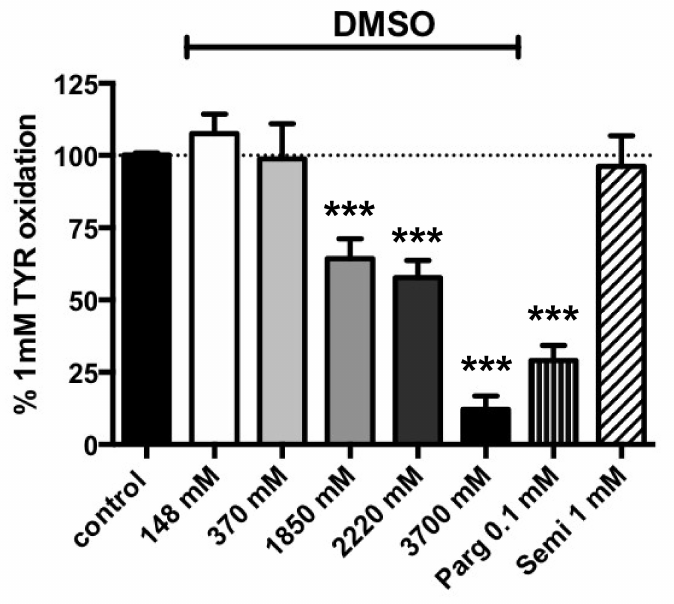
Figure 5. Interaction between DMSO vehicle and tyramine oxidation by human abdominal ScAT. Assays were performed at 37 ◦ C with homogenates and 1.0 mM tyramine as a control plus the indicated final concentration of: DMSO, Parg: pargyline; Semi: semicarbazide. The highest tested dose of DMSO (3700 mM) corresponds to its final concentration (25% v / v) when used as the vehicle for solubilization of 2.5 mM theobromine. The amount of H 2 O 2 generated during 30-min oxidation of tyramine (averaging 0.42 nmoles / mg protein / min) was set at 100% (dotted line), with the baseline set at 0%. Mean ± SEM of n = 8–12 di ff erent individual preparations. Di ff erent from control at: *** p < 0.001, determined by one-way